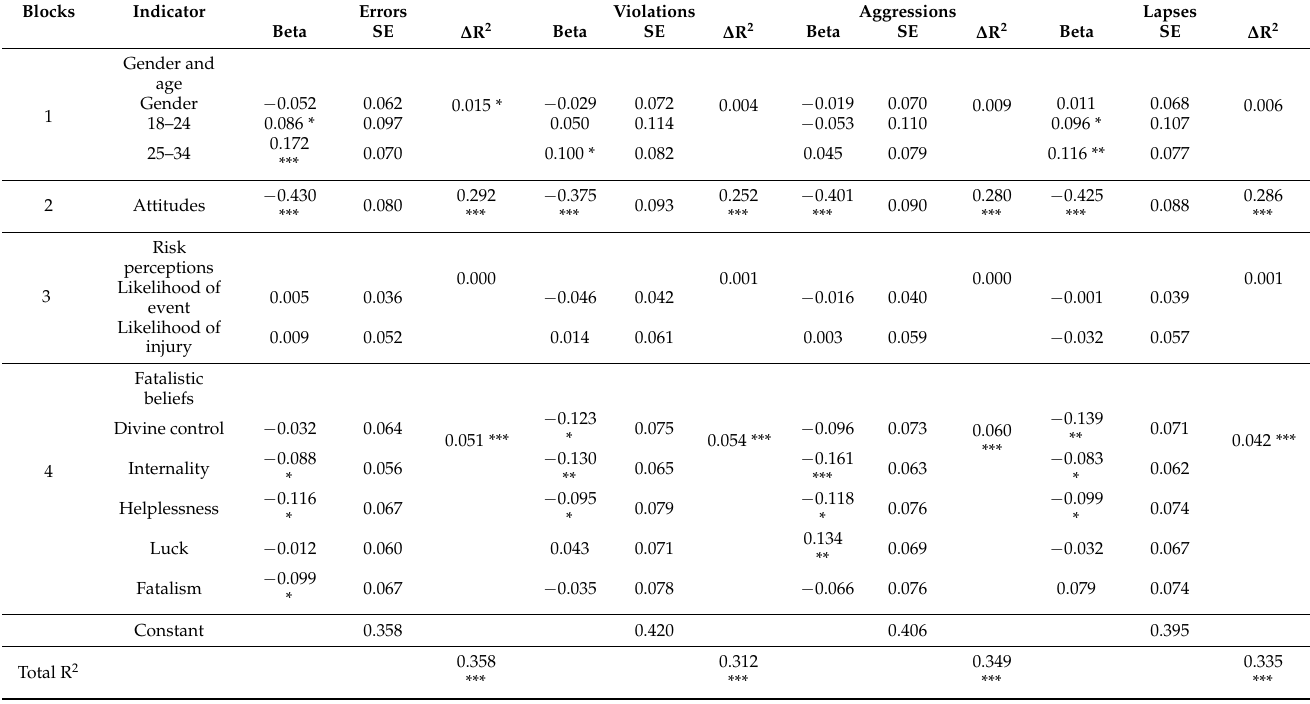
Table 6. Results of the regression models for pedestrian